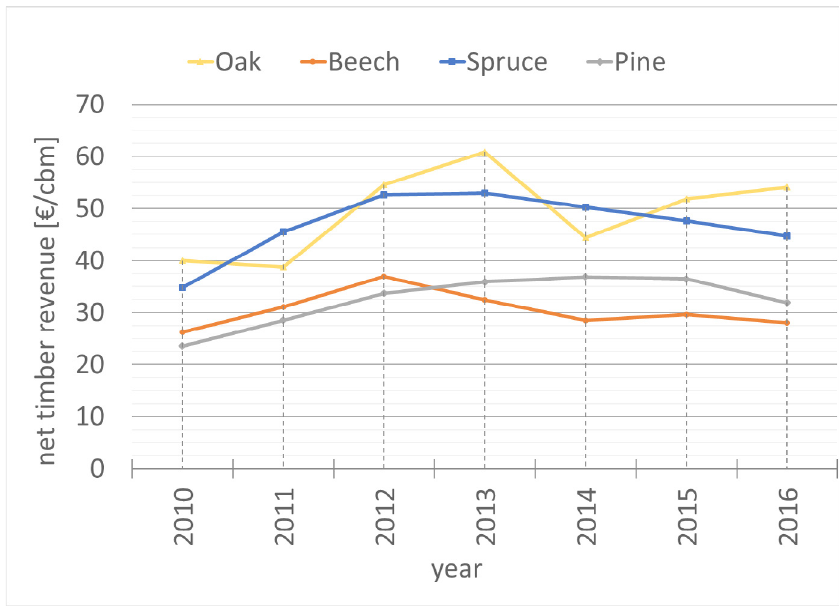
Figure 6: Net timber revenue per cubic meter according to main tree species